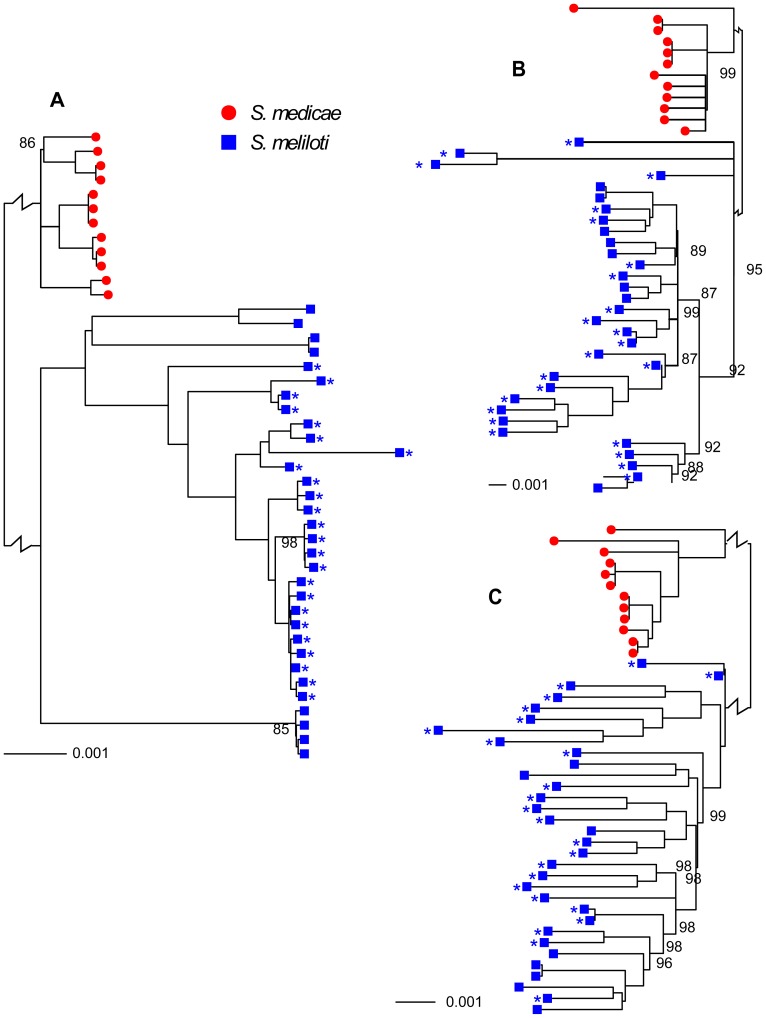
Neighbor-joining trees showing relationships among 32 S. meliloti (blue squares) and 12 S. medicae (red circles).A) chromosomes, B) pSymA and pSMED02, and C) pSymB and pSMED01. Trees were constructed using sequences from coding regions only. The length of the branch separating S. medicae from S. meliloti strains is shown at a scale that is 5% of the true scale. The 24-strain S. meliloti group is marked by asterisks. All branches had 100% bootstrap support unless otherwise indicated. Branches with <80% bootstrap support were collapsed into polytomies. An identical tree with strain identifications is provided as Figure S2.